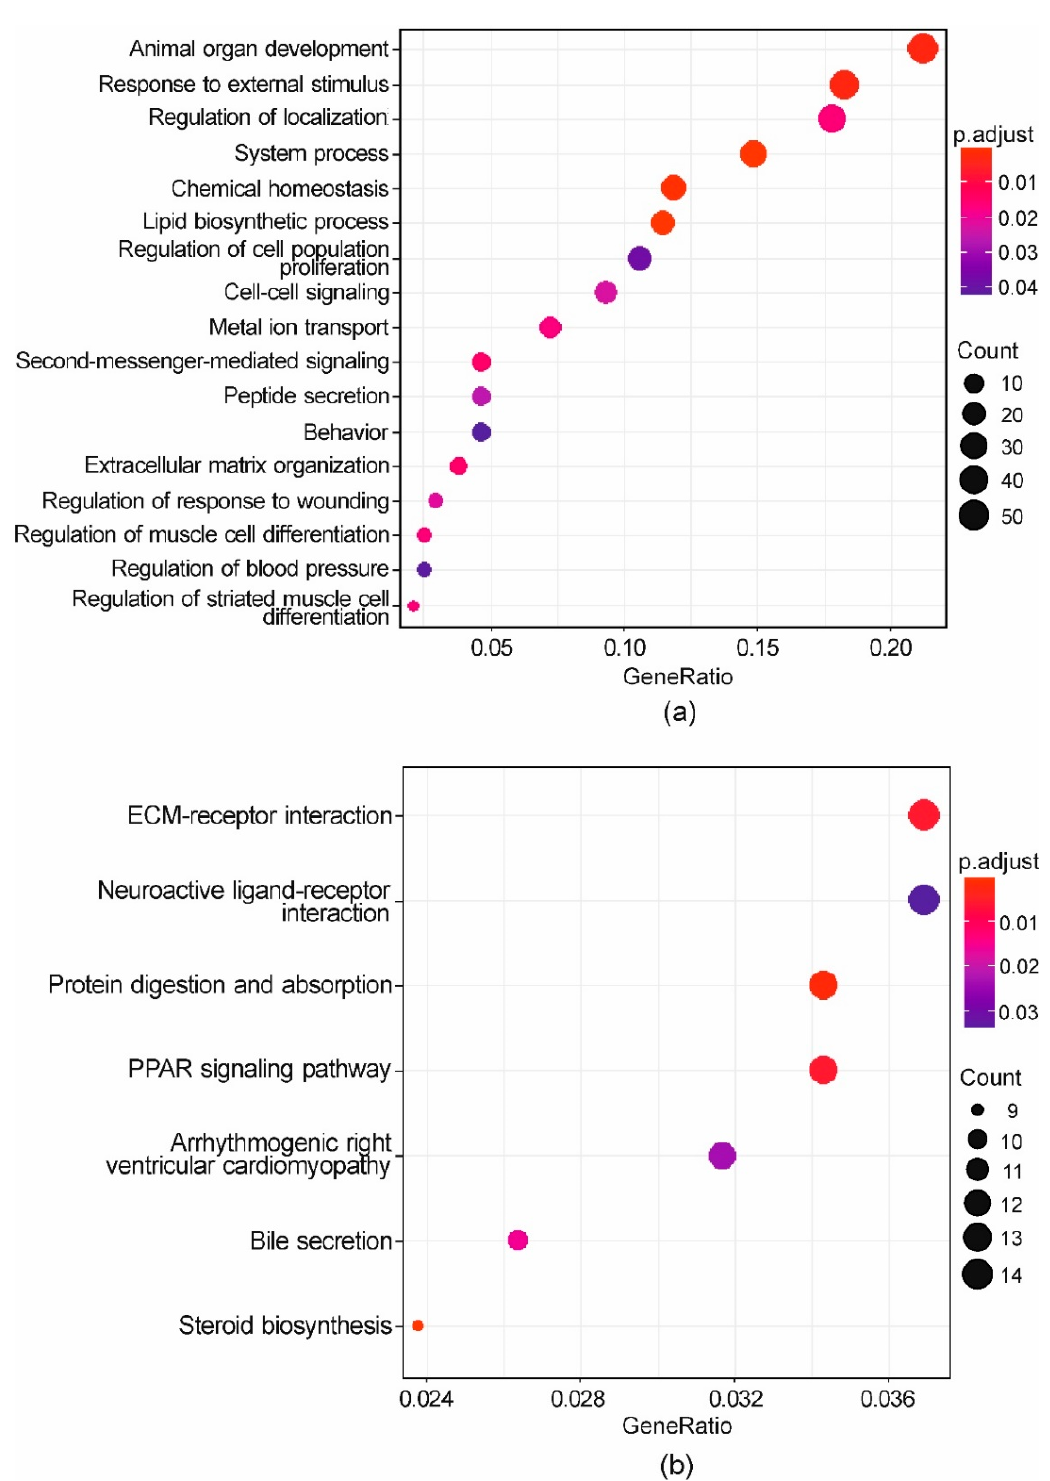
Figure 4. Functional enrichment of genes regulated by R+AFB1 co-treatment (vs. AFB1). Dot plots representing enriched BPs ( a ) and KEGG pathways ( b ). Dot size reflects the number of DEGs in each enriched term. The colour gradient reflects the significance level of each term. p -values were adjusted using the Benjamini-Hochberg method.